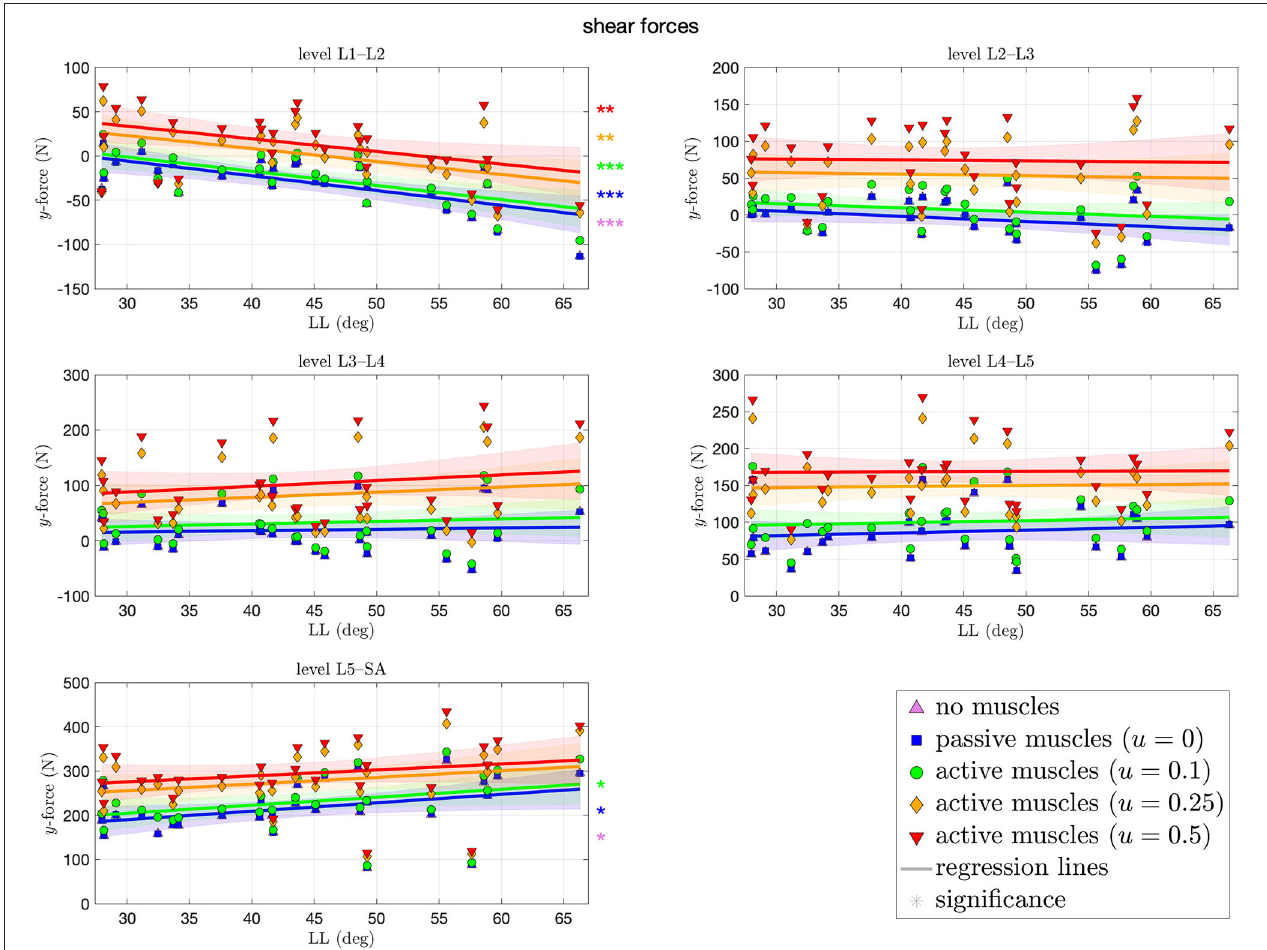
FIGURE 6 | Shear ( y -)force between each pair of adjacent vertebrae against lumbar lordosis (LL). Colors and marker symbols of the data points and the corresponding regression lines consistently correspond to the modes: lilac up-pointing triangles for simulations without muscles involved; blue squares for passive muscles; as well as green circles, orange diamonds, and red down-pointing triangles for muscle stimulation of u the regression are shown as pale areas of the corresponding